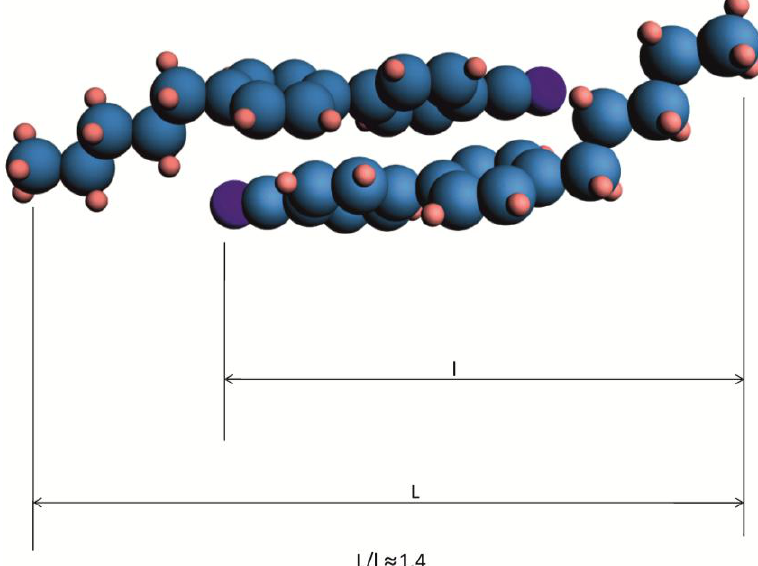
Figure 9. Model of 5 CB dimer. L/l ≈ 1.4. L—length of dimer, l—length of